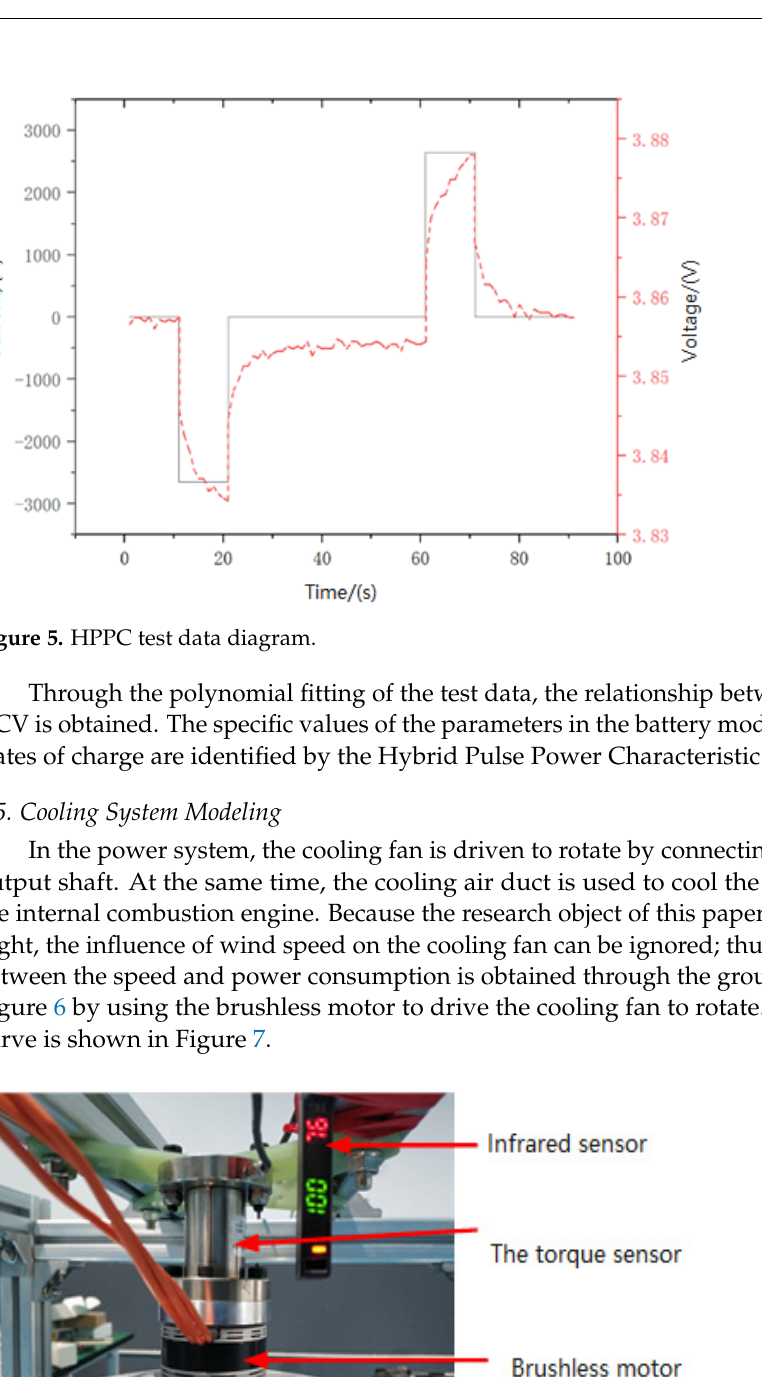
Figure 7. Torque–speed curve of cooling fan. 3. Energy Management Strategy 3.1. Introduction In sequential decision problems, the Markov decision model (MDP) [27–29] is a math- ematical model that simulates the randomness strategy and return of agents when the system state has Markov properties. The Markov property is a common property of all Markov models, which means that the current state is only related to the state and action of the previous discrete time point, and is independent of the state and action of other times. In the existing decision-making model, it can promptly discard useless historical information and avoid excessive processing of signal coupling, which helps it to take the lead in terms of the learning efficiency and effectiveness of random strategies. While sim- plifying the problem, it retains the main relationship, and can predict the future only based on the one-step dynamics of the environment. With its great simplicity and effi- ciency in the research process, some environments that do not fully have Markov proper- ties have also been modeled by scholars using MDP, and have achieved good results. 𝑝(𝑠 (cid:3036)(cid:2878)(cid:2869) ∣ 𝑠 (cid:3036) , 𝑎 (cid:3036) , ⋯ , 𝑠 (cid:2868) , 𝑎 (cid:2868) ) = 𝑝(𝑠 (cid:3036)(cid:2878)(cid:2869) ∣ 𝑠 (cid:3036) , 𝑎 (cid:3036) ) (5) The reinforcement learning algorithm is an intelligent algorithm to solve the cumu- lative revenue problem under discrete-time MDP. In this paper, we adopt the double Q learning algorithm, which is derived from the Q-learning algorithm in the reinforcement